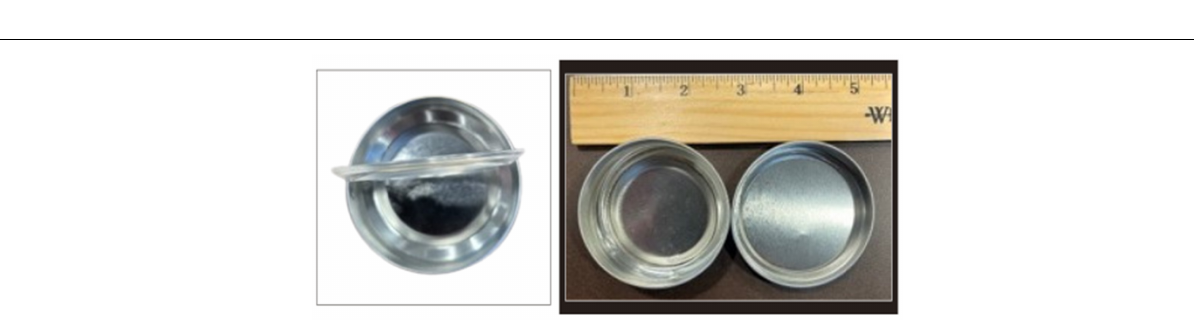
FIGURE 4 | Training aid delivery device (TADD) breakout diagram (A) and photograph (B) .